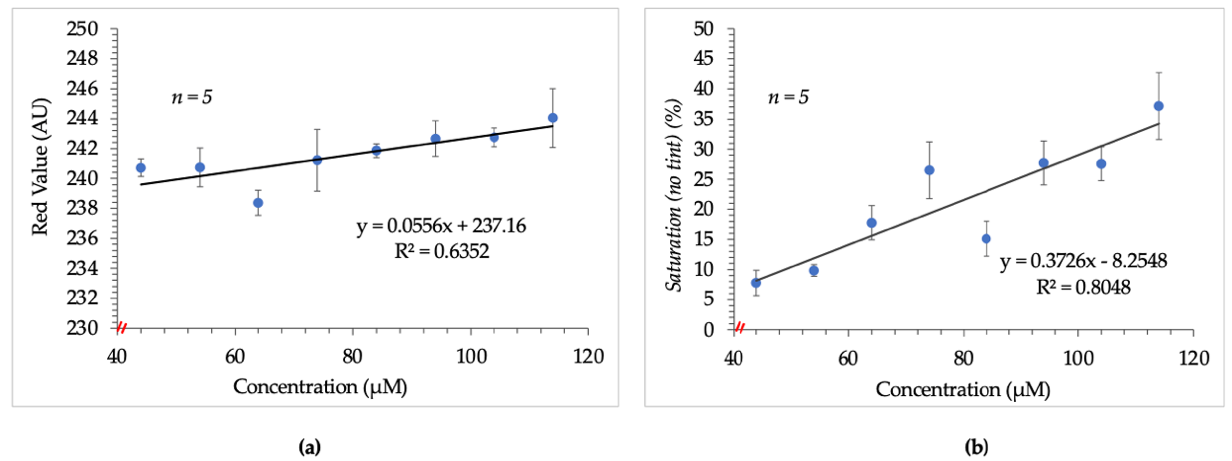
Figure 1. Results obtained from initial image analysis techniques. ( a ) shows the poor linear relationship between arginine concentration and average red value. ( b ) shows the slightly improved but non-ideal relationship observed between saturation and arginine concentration. Images were tinted prior to saturation measurement thereafter to address this issue.